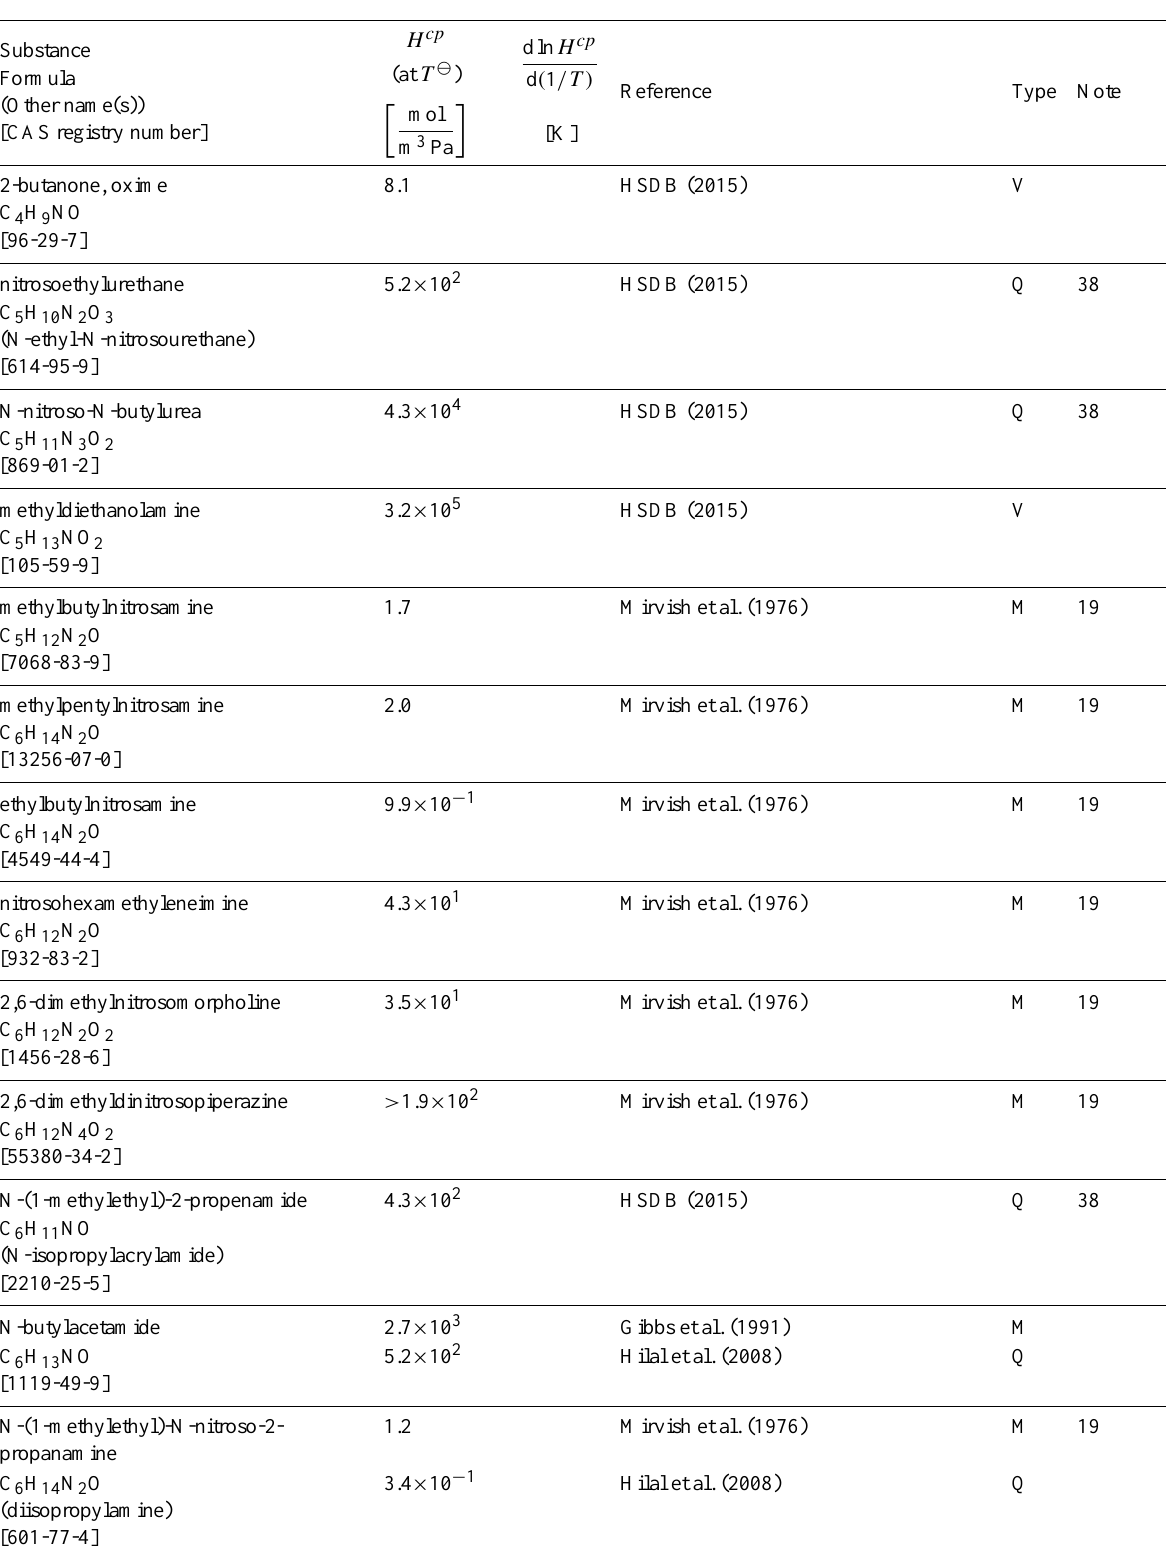
Table 6: Henry’s law constants for water as solvent